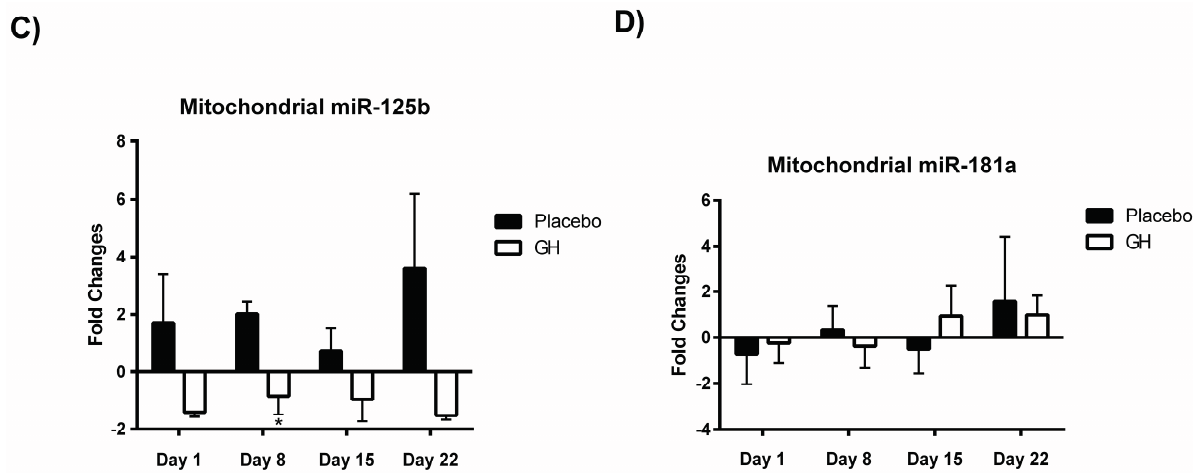
Figure 3. ( A ) Changes from baseline measurements in the expression of miR-125b miRNA levels from the cytosol of PBMCs in rhGH treated compared to placebo treated samples; ( B ) Changes from baseline measurements in the expression of miR-181a miRNA levels from the cytosol of PBMCs in rhGH treated compared to placebo treated samples; ( C ) Changes from baseline measurements in the expression of miR-125b miRNA levels from isolated PBMC mitochondria in rhGH treated compared to placebo treated samples; ( D ) Changes from baseline measurements in the expression of miR-181a miRNA levels from isolated PBMC mitochondria in rhGH treated compared to placebo treated samples. ( * p < 0.05 compared to